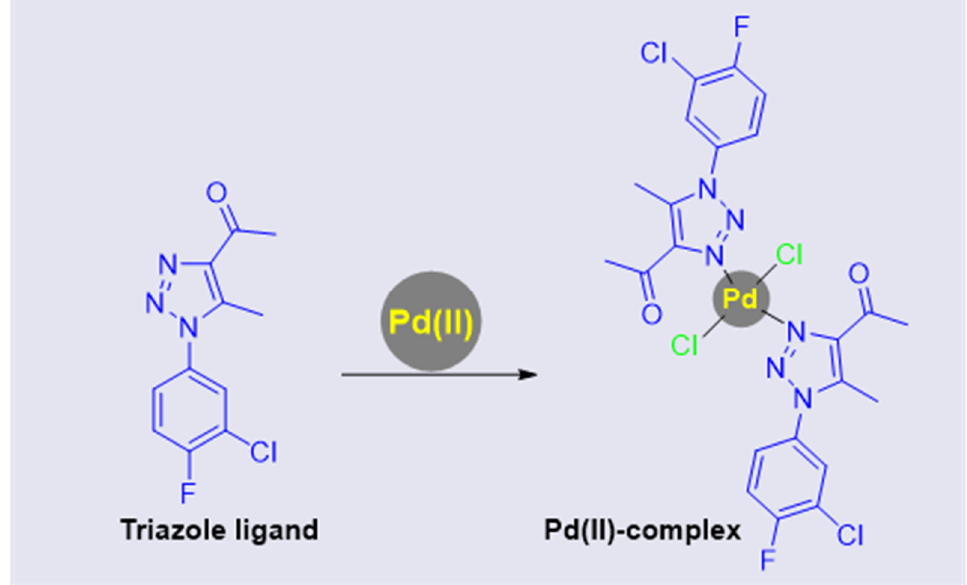
Figure 1. Triazole framework and its Pd(II)